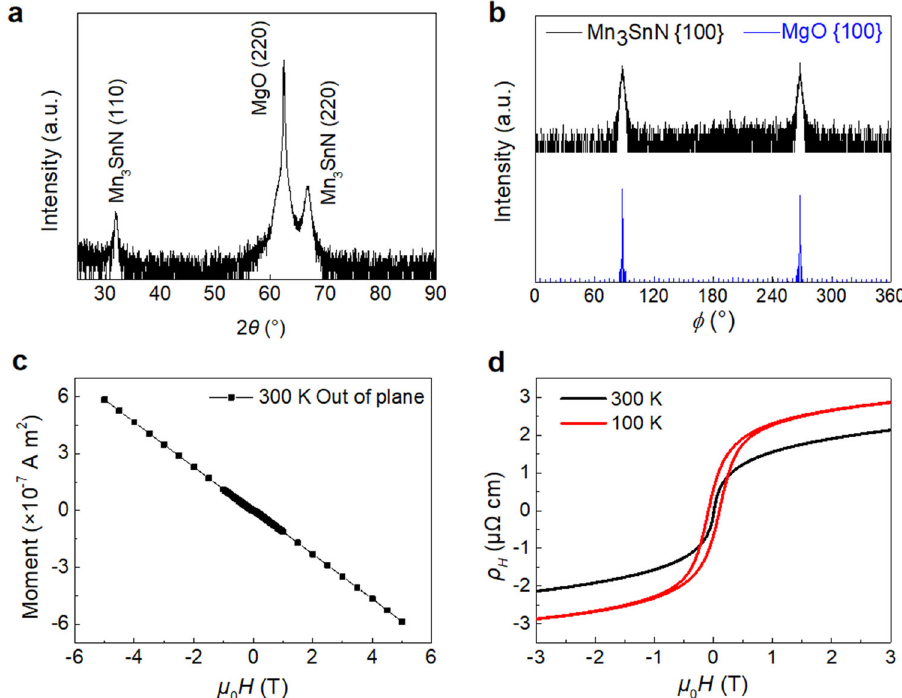
Fig. 2 Basic properties of the Mn 3 SnN fi lm. a XRD patterns of the (110)-oriented Mn 3 SnN fi lms deposited on MgO (110) substrate. b Φ scan patterns of the {100} planes from the Mn 3 SnN fi lms and the MgO (110) substrate. c Magnetization hysteresis loops of the 34 nm Mn 3 SnN (110) fi lm deposited on MgO (110) substrate by an out-of-plane magnetic fi eld at 300 K. d Magnetic fi eld dependence of ρ H measured with an out-of-plane magnetic fi eld at 300 and 100 K, which exhibits obvious AHE in the fi